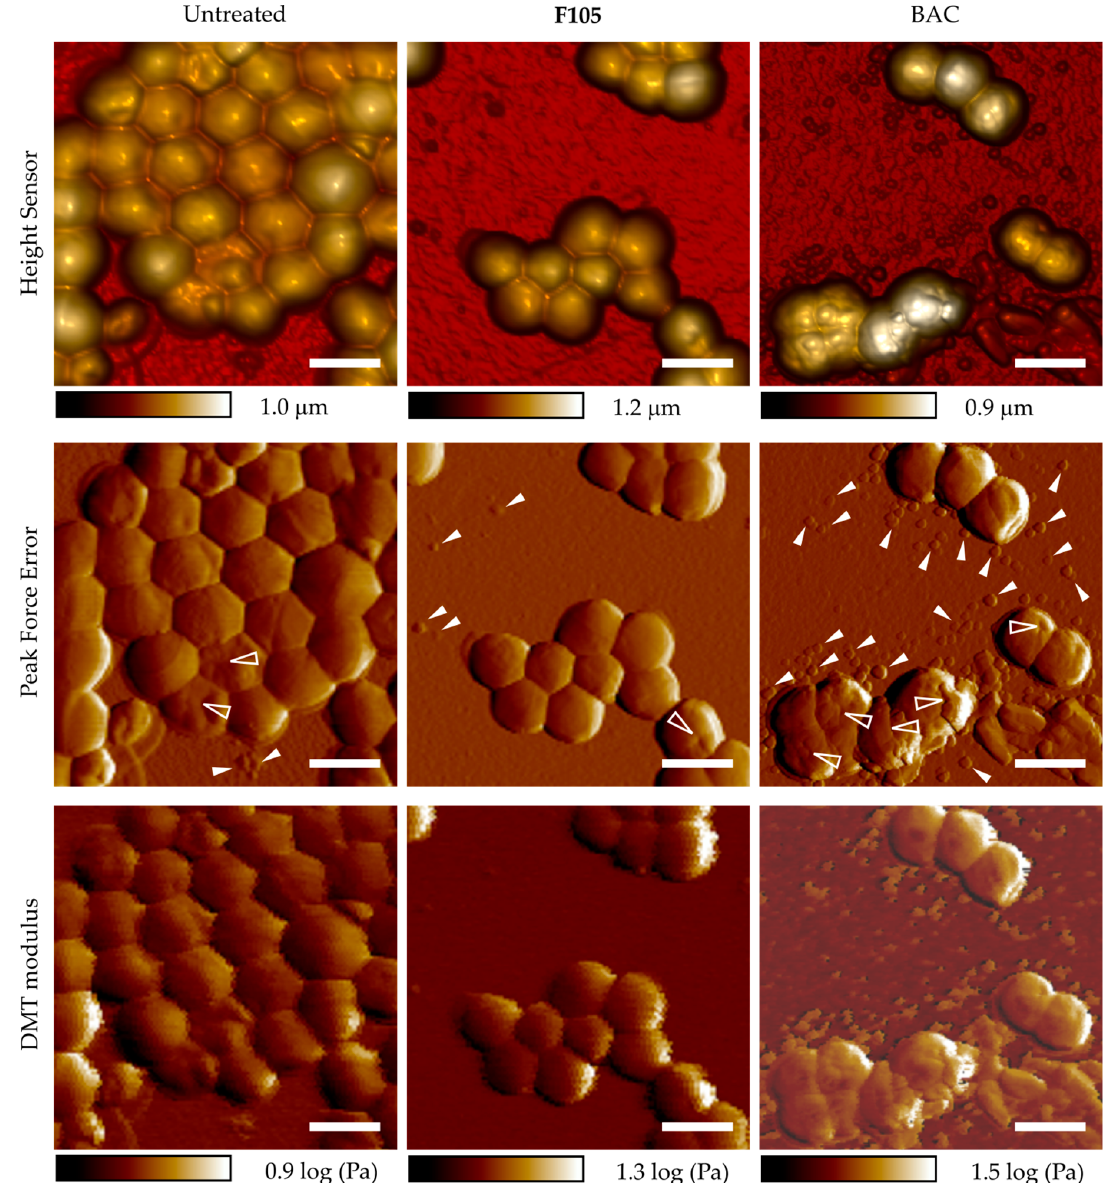
Figure 7. Atomic force microscopy (peak force tapping mode) images of S. aureus planktonic cells after 18 h incubation with 4 µ g/mL of BAC or 32 µ g/mL of F105 (in correspondence with their respective MBCs). Scale bar is 2 µ m. Cell wall damage is shown with transparent arrows; cell debris particles and organic substances are shown with white arrows).